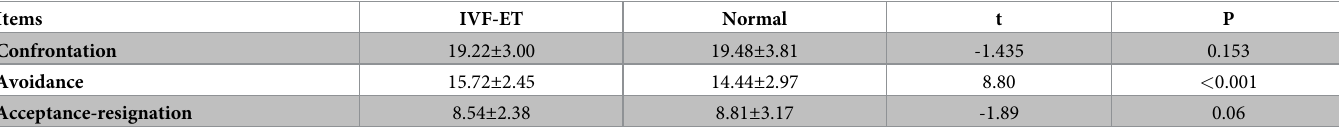
Table 2. Comparisons of scores on the medical coping modes questionnaire of patients treated with IVF-ET and normal controls.